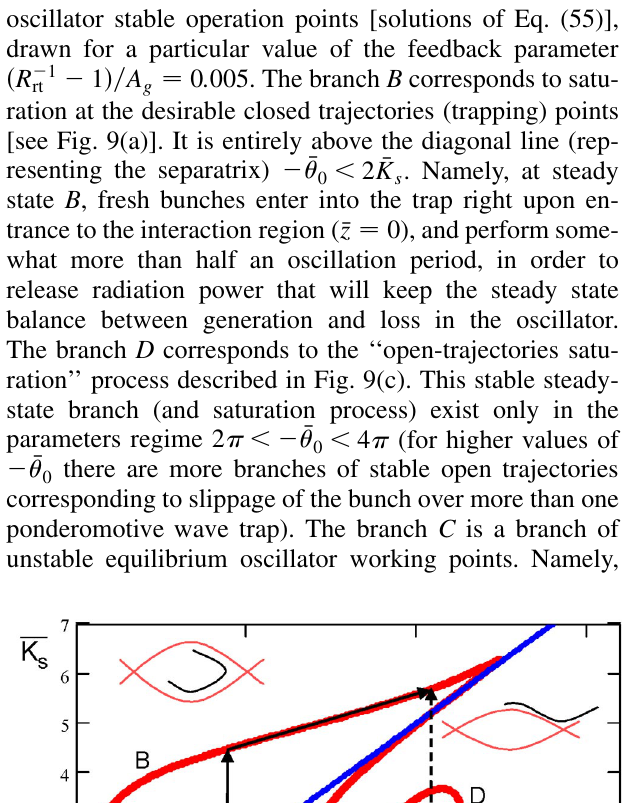
(cid:6) 1 (cid:4) =A (cid:1) 0 : 005 . g rt